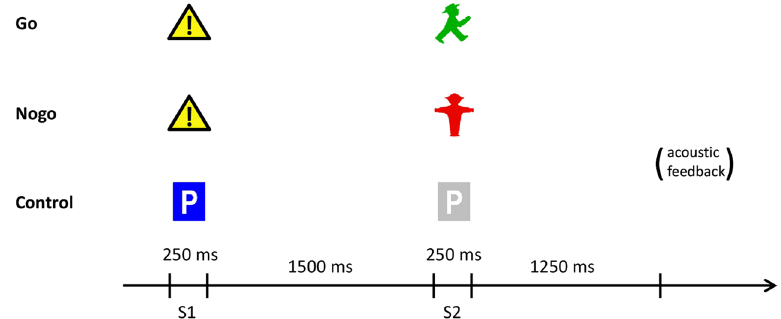
Figure 3. Schematic illustration of the cued go/nogo task (S1–S2 paradigm). Traffic sign icons were used as stimuli. All trial types (go, nogo and control) occurred with equal probability. In block 2 and block 3 of the task, monetary incentives were used. Money won or lost in a trial was indicated by corresponding acoustic feedback. For details see text.